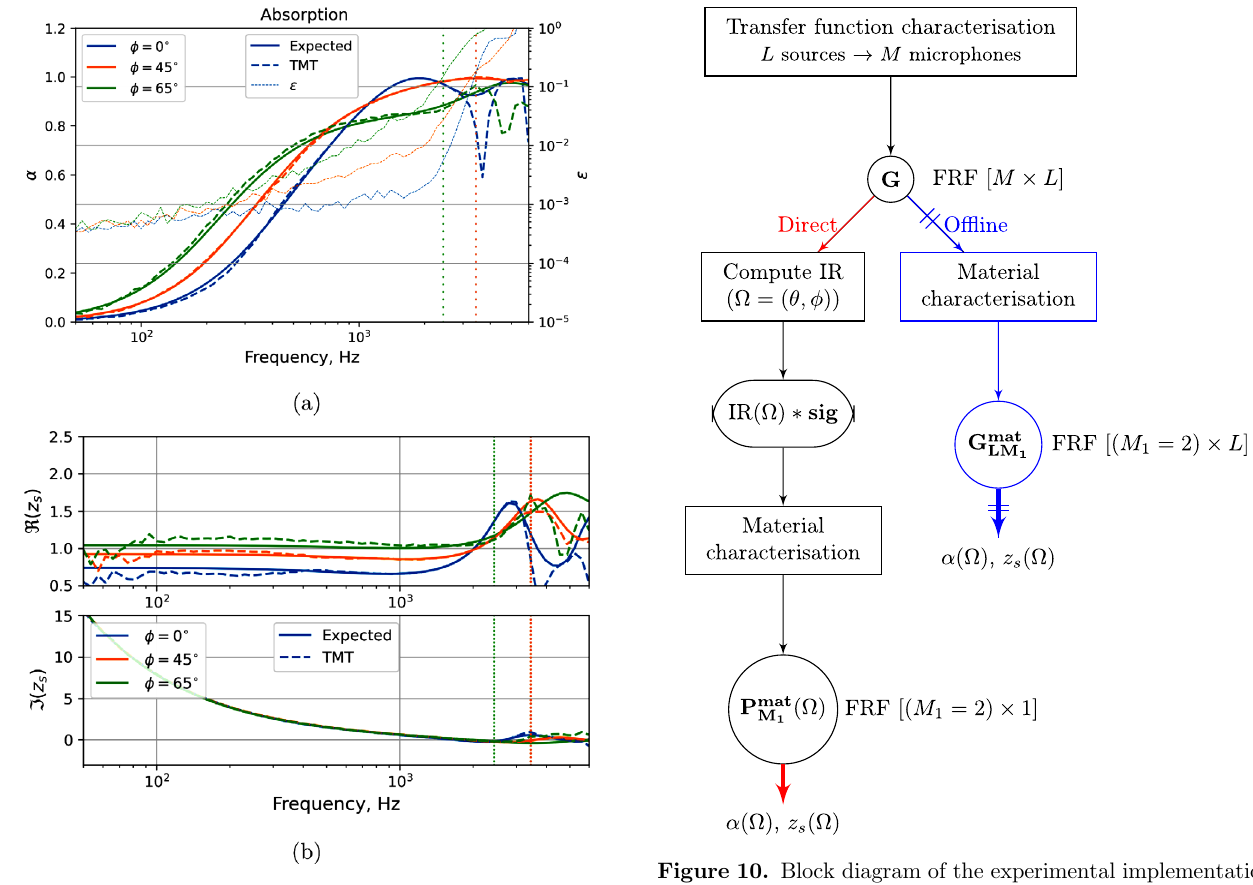
Figure 9. Absorption coef fi cient a and reconstruction error (a), normalized surface impedance z s (b), for the con fi guration shown in Figure 1 for three incidence angles with a = 105 cm, b = 40 cm, k = 10 (cid:3) 7 , d = 2 cm, z a = 0.5 cm and added noise.